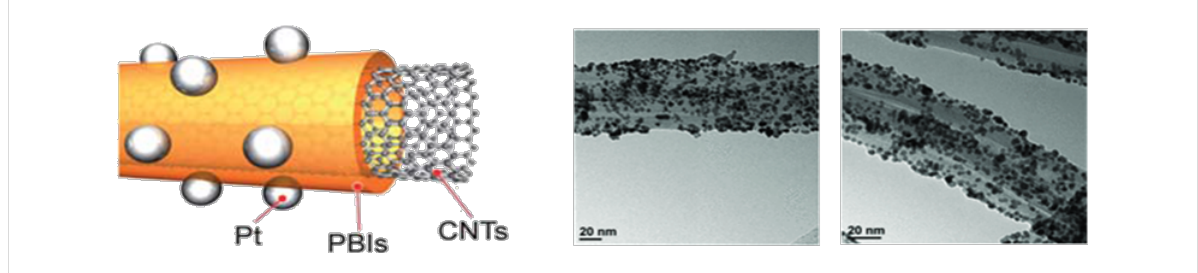
Figure 7: Left: Schematic drawing of an electrocatalyst composed of Pt nanoparticles loaded on the PBIs-wrapped carbon nanotubes (left). Reprinted with permission from [48], Copyright 2011 Royal Society of Chemistry. Right: TEM images of Pt nano-particles loaded on the PBIs-wrapped carbon nanotubes (right). Reprinted with permission from [49]. Copyright 2013 Wiley-VCH.